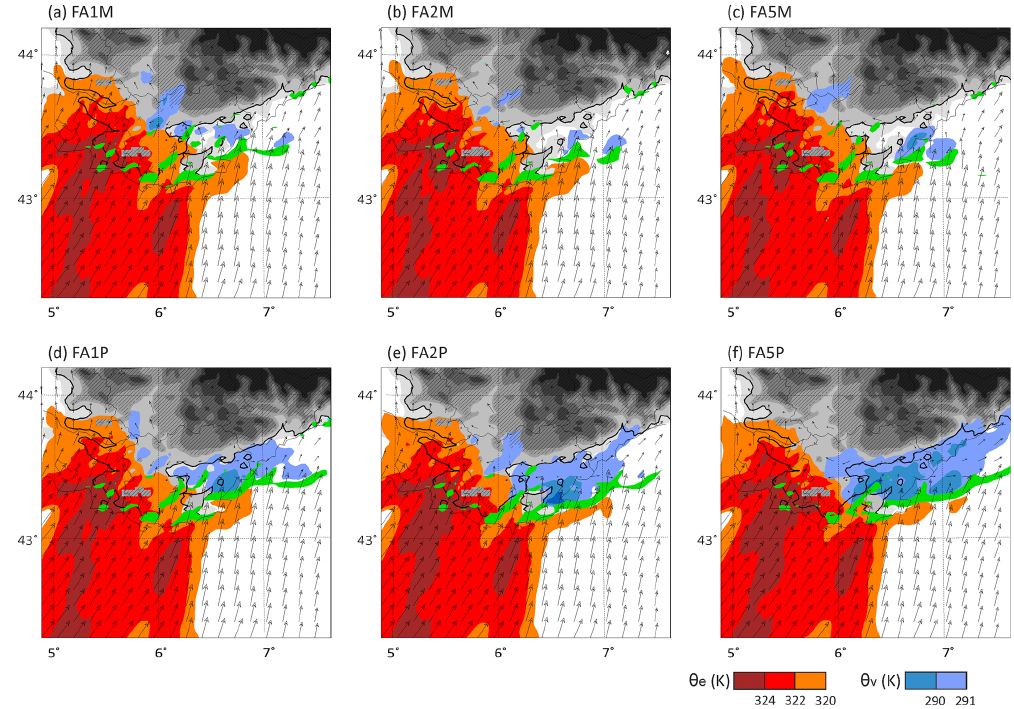
Figure 15. Same as Fig. 11 for (a) FA1M, (b) FA2M, (c) FA5M, (d) FA1P, (e) FA2P, and (f) FA5P at 15:00UTC on 14 October 2012.